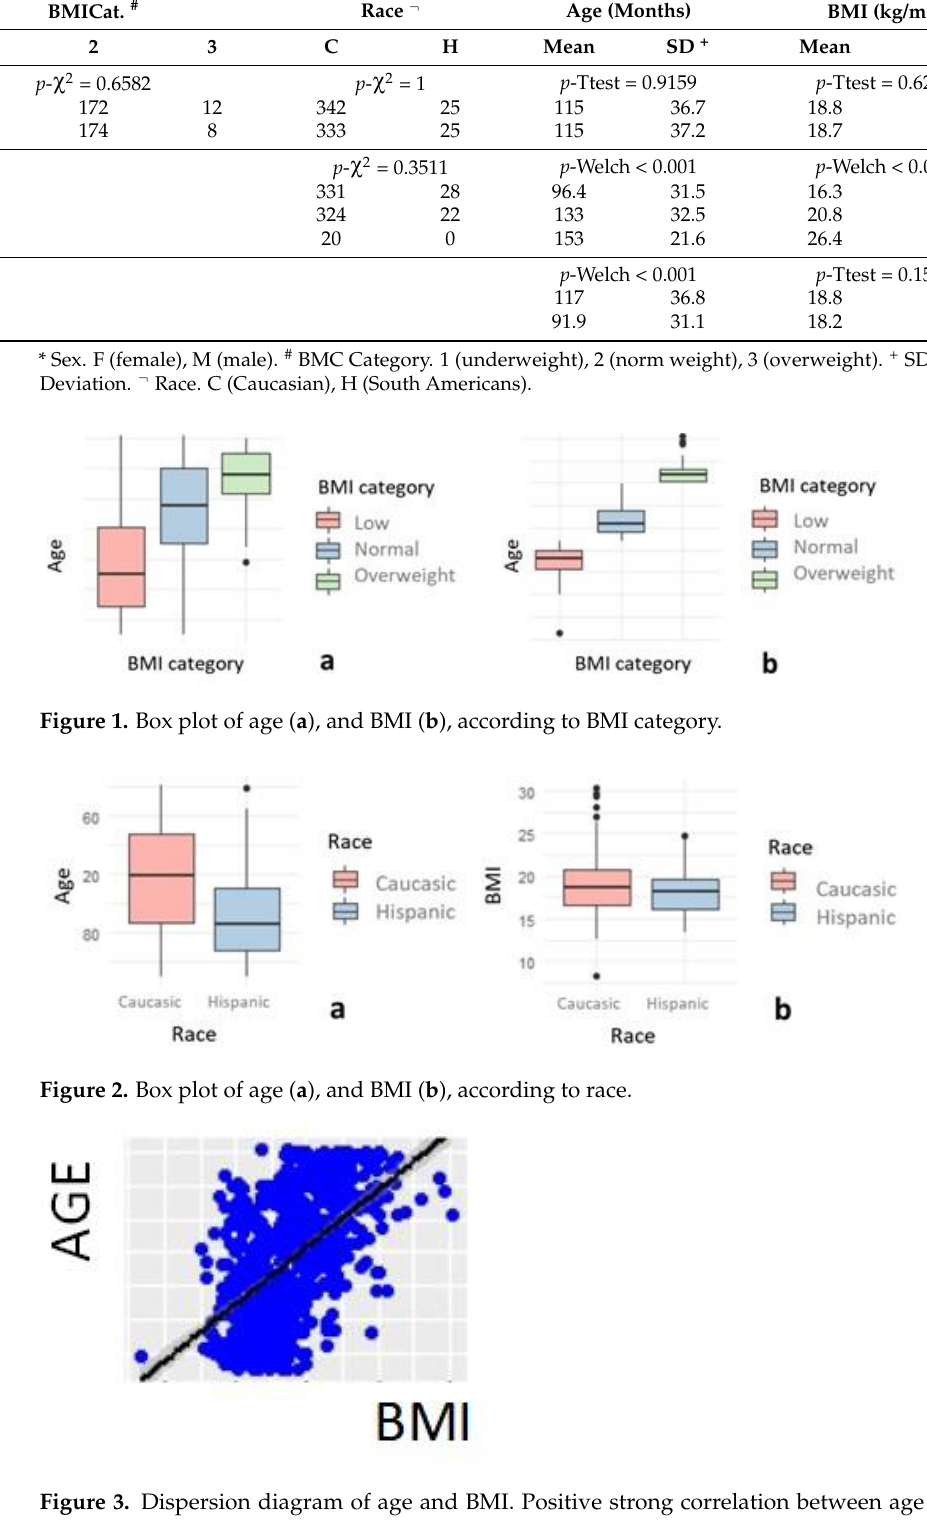
Table 1 . Relationship between the variables BMI category, race, sex, age, height, weight, and BMI. BMICat. #